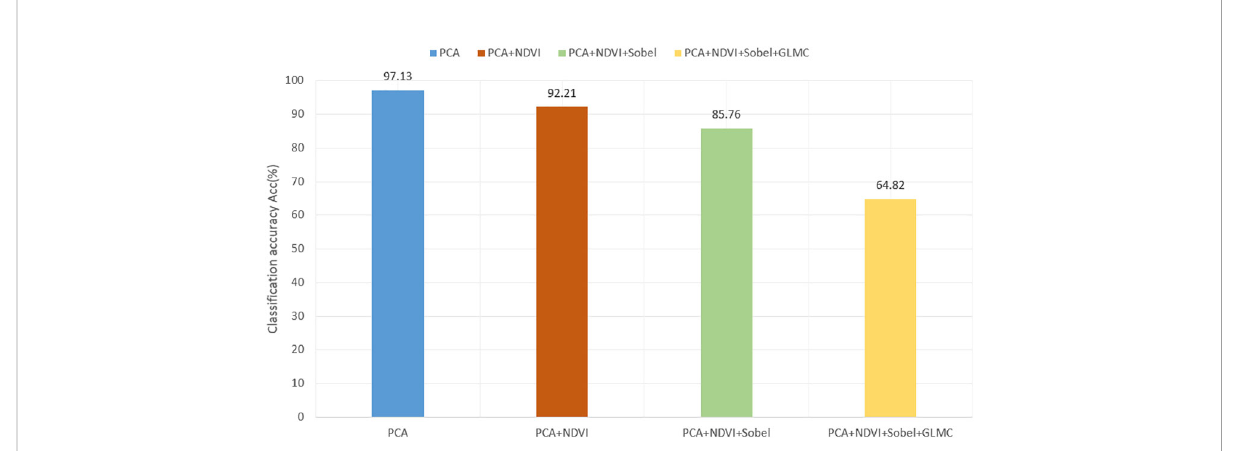
FIGURE 11 The comparison of overall classi fi cation accuracy of different feature fusion ways in single